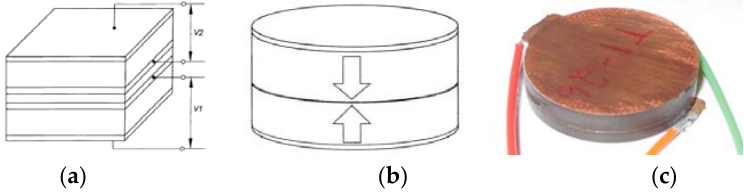
Figure 15. Different configurations of Transoner radial-type piezoelectric transformer: ( a ) square-shape Transoner; ( b ) disc-shape Transoner; ( c ) commercial sample of non-isolated Transoner piezoelectric transformer [78,79].